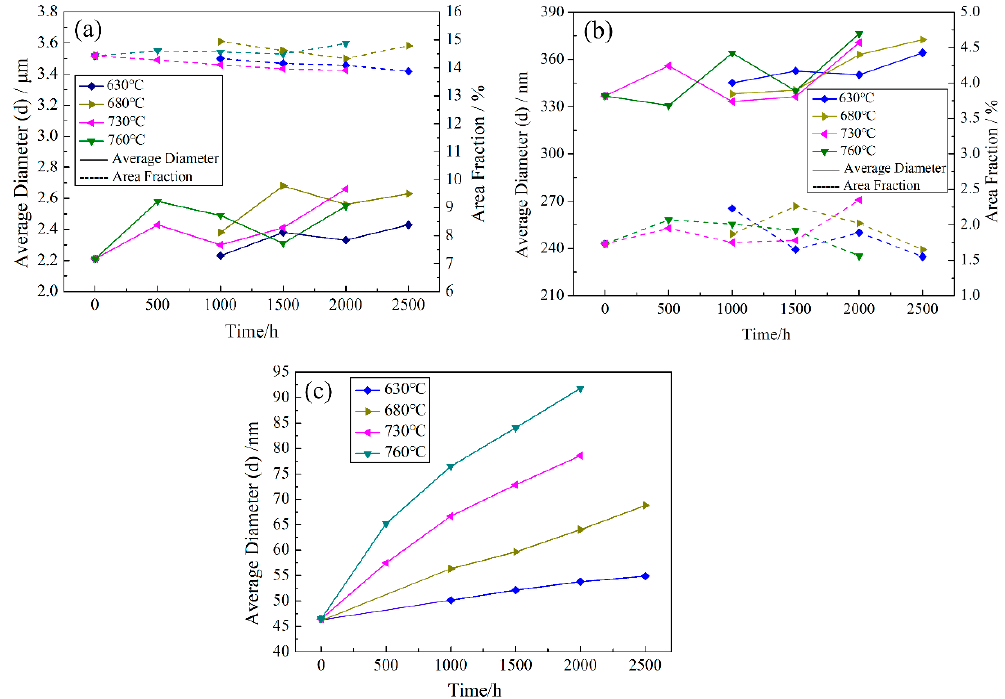
Figure 5. The variations of average diameter and area fraction of primary ( a ), secondary ( b ) and tertiary ( c ) γ’ precipitates during thermal exposure.